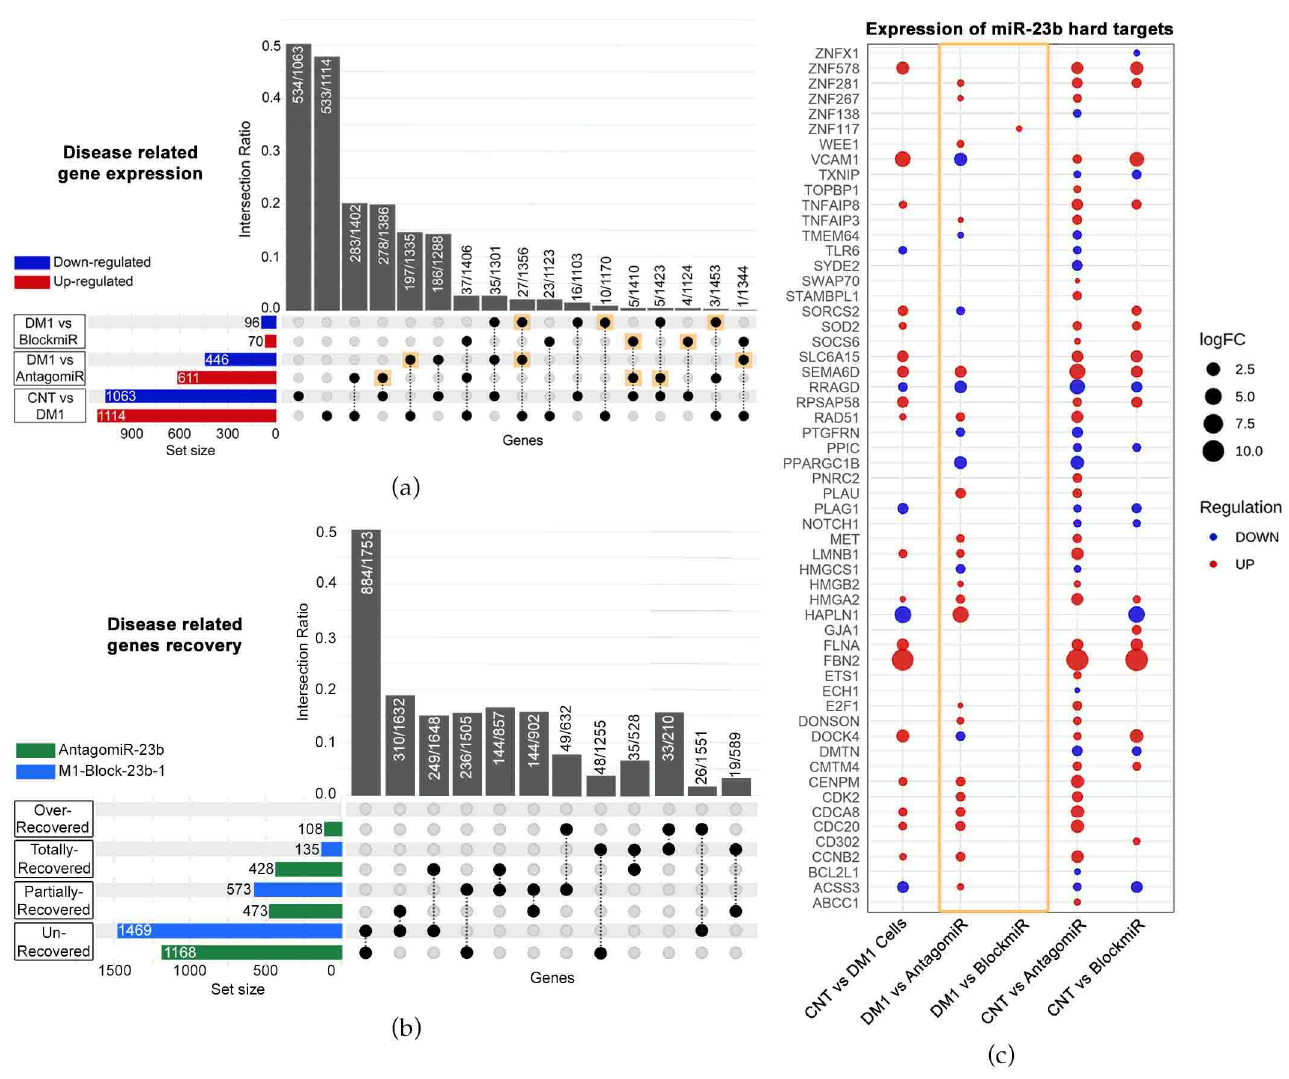
Figure 4. The transcriptomes of BlockmiR- vs. AntagomiR-treated DM1 cells. ( a ) When comparing CNT to DM1 cells, 2177 altered genes were labeled disease-related genes. A total of 1057 genes and 166 genes were altered after AntagomiR-23b (AntagomiR) and M1-Block-23b-1 (BlockmiR) treatment, respectively, in comparison to untreated DM1 cells. These numbers can be seen by summing the number of genes up- or down-regulated in the respective red and blue horizontal bars to the left of each comparison. The black circles and dotted lines show which genes are common to each group. The number of these shared genes divided by the total number of unaffected genes from the groups is calculated as the intersection ratio. ( b ) The number of genes with recovery of disease-related genes can be seen for both AntagomiR (green bar) and BlockmiR (blue bar). Unrecovered < 10%; partially recovered between 10% and 50%; total recovery between 50% and 150%; over recovered > 150%. The black circles and do tt ed lines show which are common to each group. The number of these shared genes divided by the total number of una ff ected genes in each group is calculated as the intersection ratio. ( c ) Geometric points are plo tt ed to represent the log2 fold change of the hard targets of miR-23b after treatment with the BlockmiR or AntagomiR. The size of each point re fl ects the intensity while the color re fl ects the over- or under-expression of each comparison. Reproduced/adapted from [29] Universitat de València, 2022.